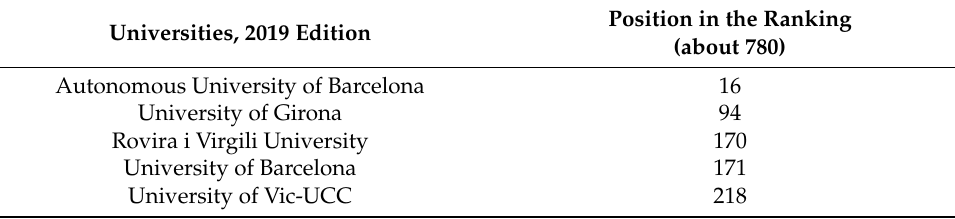
Table 19. Catalan universities included in the GreenMetric ranking. Source: